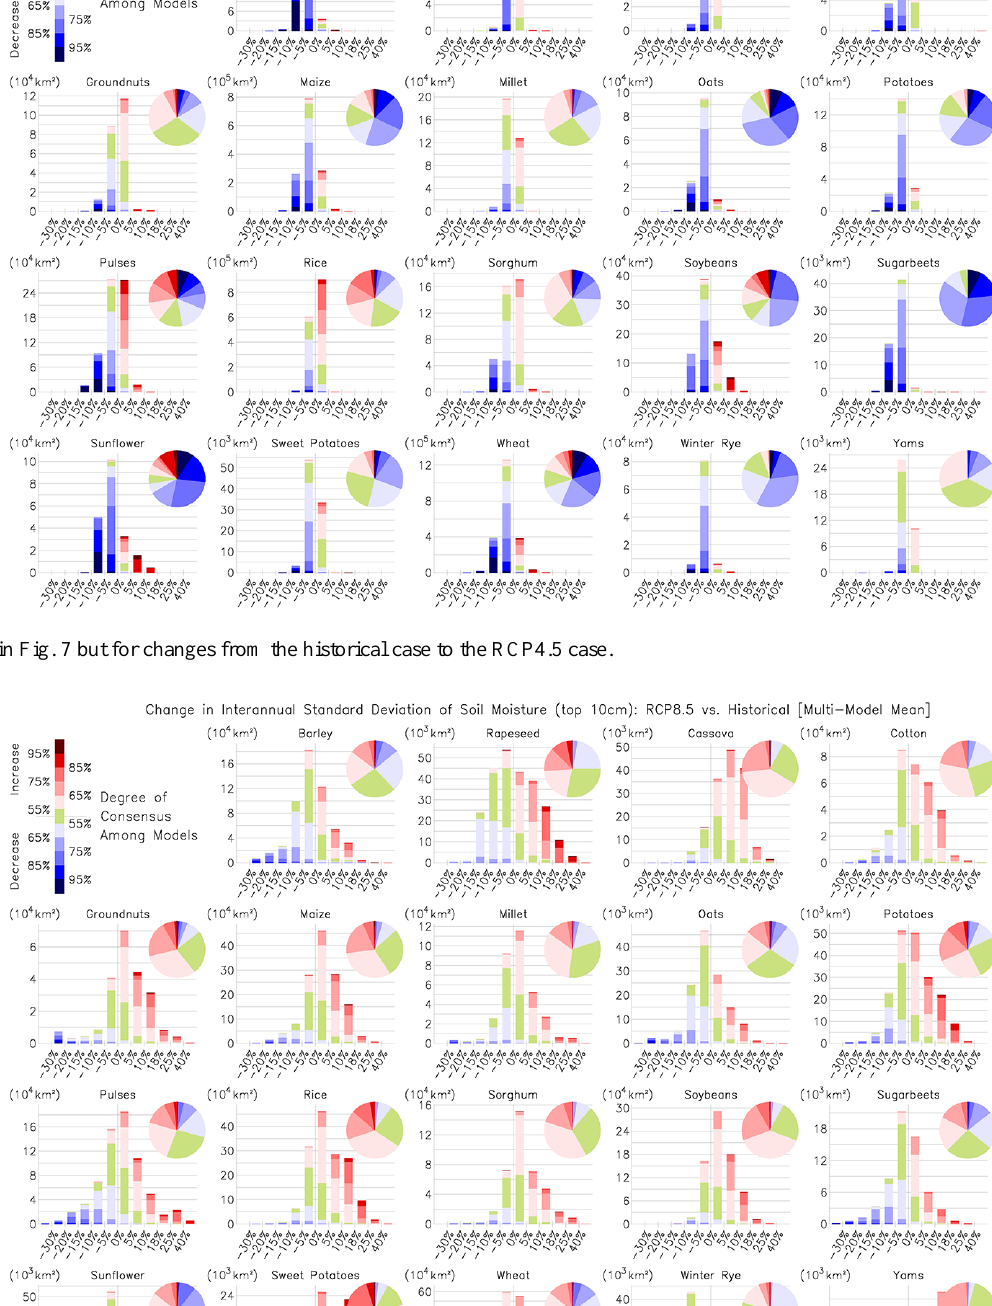
Hydrol. Earth Syst. Sci., 18, 5317–5329, 2014